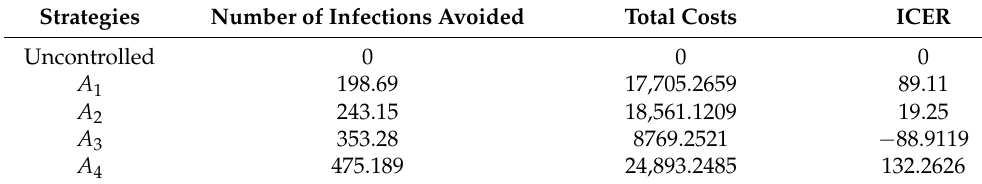
Table 2. Comparison of strategic cost table. Strategies Number of Infections Avoided Total Costs ICER Uncontrolled